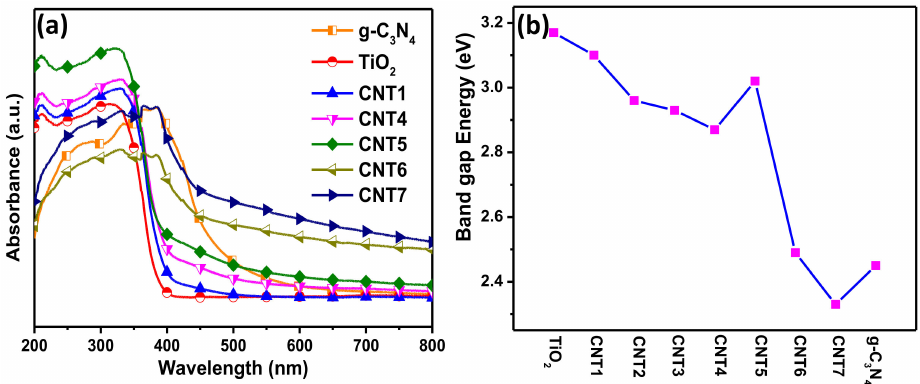
Figure 6. ( a ) UV-vis diffuses reflectance spectra of g-C 3 N 4 , TiO 2 nanofibers and various CNT composites; ( b ) The curve of band gap energy in various samples.